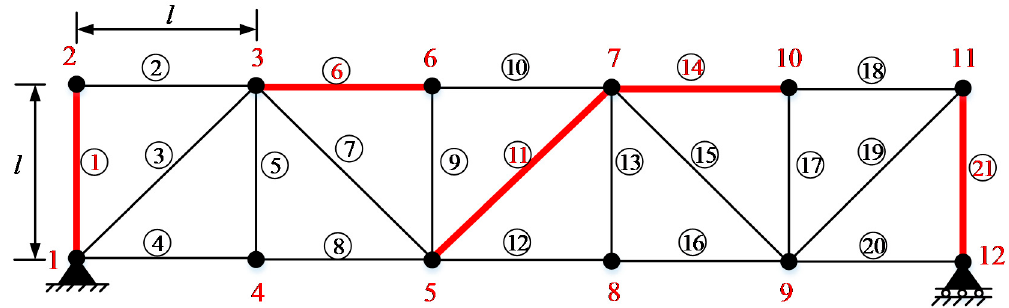
Figure 3. Truss elements and nodes diagrams.